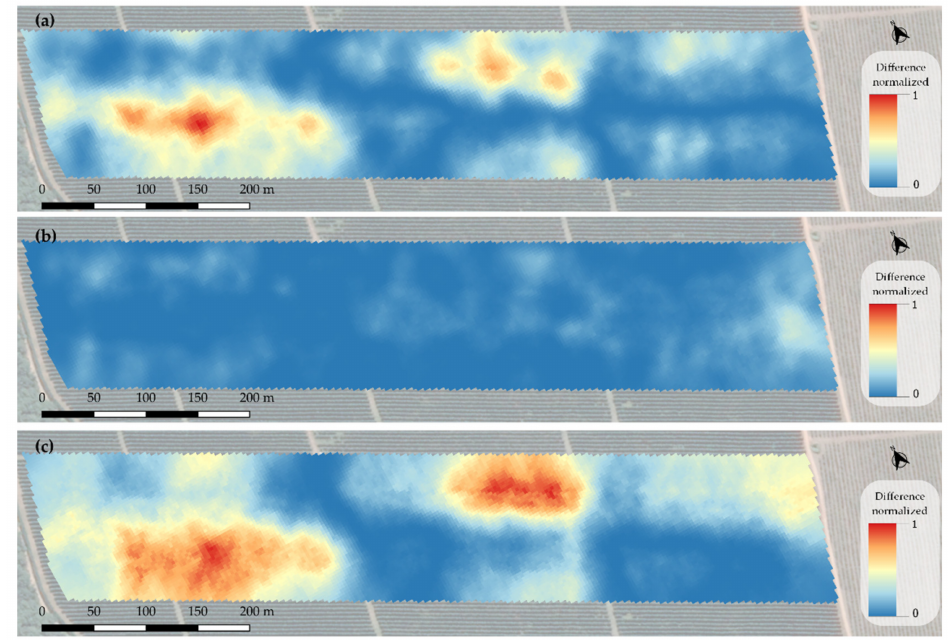
Figure 9. Normalized difference map between yield data between crops 2019 and 2020 ( a ), 2019 and 2021 ( b ), and 2020 and 2021 ( c